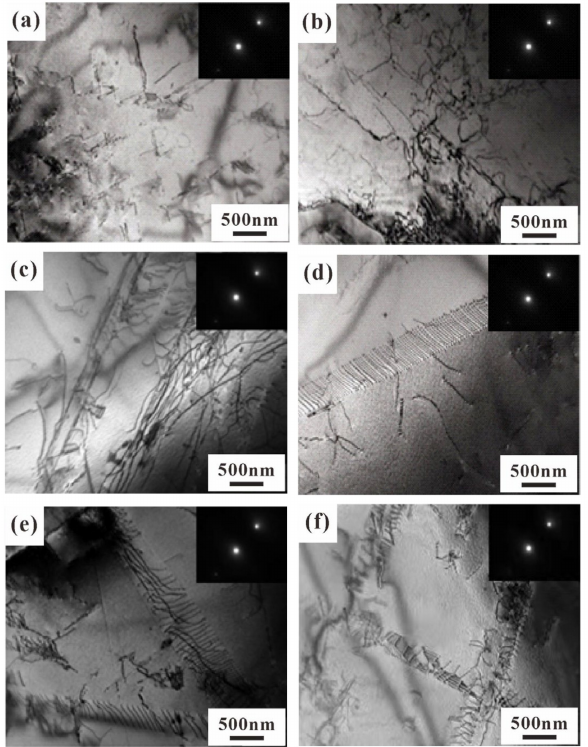
Figure 5. TEM images of dislocation morphology in as-cast and cryogenically treated Al 0.6 CrFe 2 Ni 2 HEAs: ( a ) as-cast; ( b ) cryogenic treatment for 4 h; ( c ) cryogenic treatment for 8 h; ( d ) cryogenic treatment for 12 h; ( e ) cryogenic treatment for 24 h; ( f ) cryogenic treatment for 48